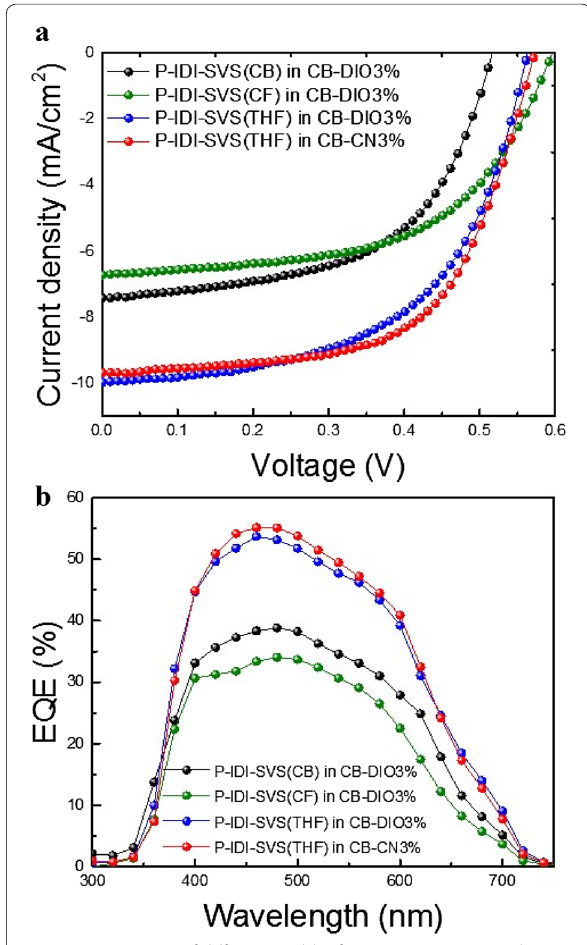
Fig. 2 a J–V curves of different Soxhlet fraction P‑IDI‑SVS BHJ devices processed, b EQE of different Soxhlet P‑IDI‑SVS BHJ devices